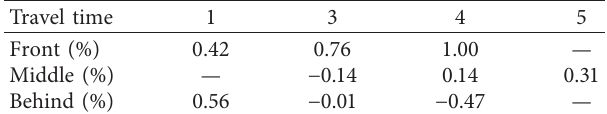
Table 3: Travel time relative difference compared with group S2.